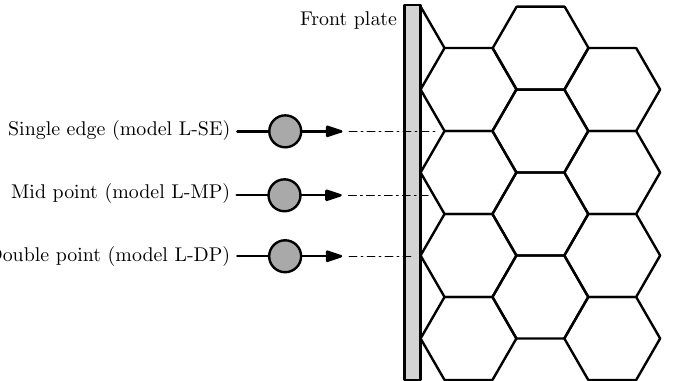
Figure 19. Location of impact on Whipple shield relative to honeycomb.